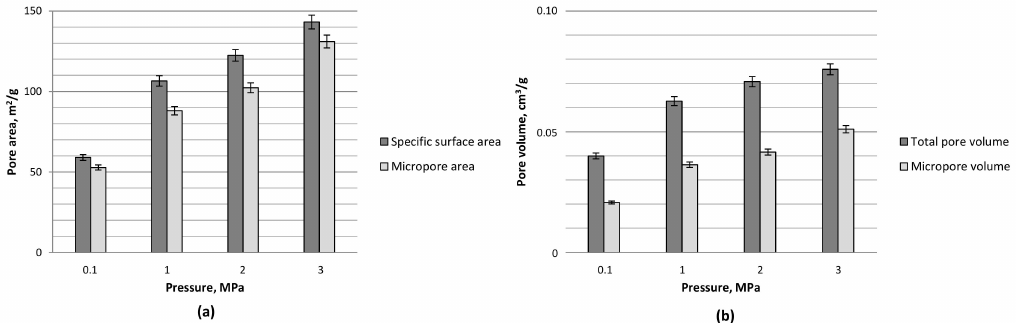
Figure 3. Porous structure parameters: ( a ) specific surface area and micropore area and ( b ) total pore volume and micropore volume, based on nitrogen isotherms at − 196 ◦ C for olive pomace-derived carbon materials produced at 800 ◦ C, carbon dioxide atmosphere, and under the pressure of 0.1–3